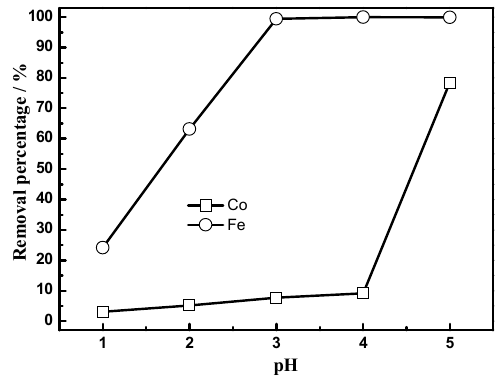
Figure 6. Effect of pH on the removal rate of iron and cobalt (soaking time = 1 h, temperature = 85 °C).